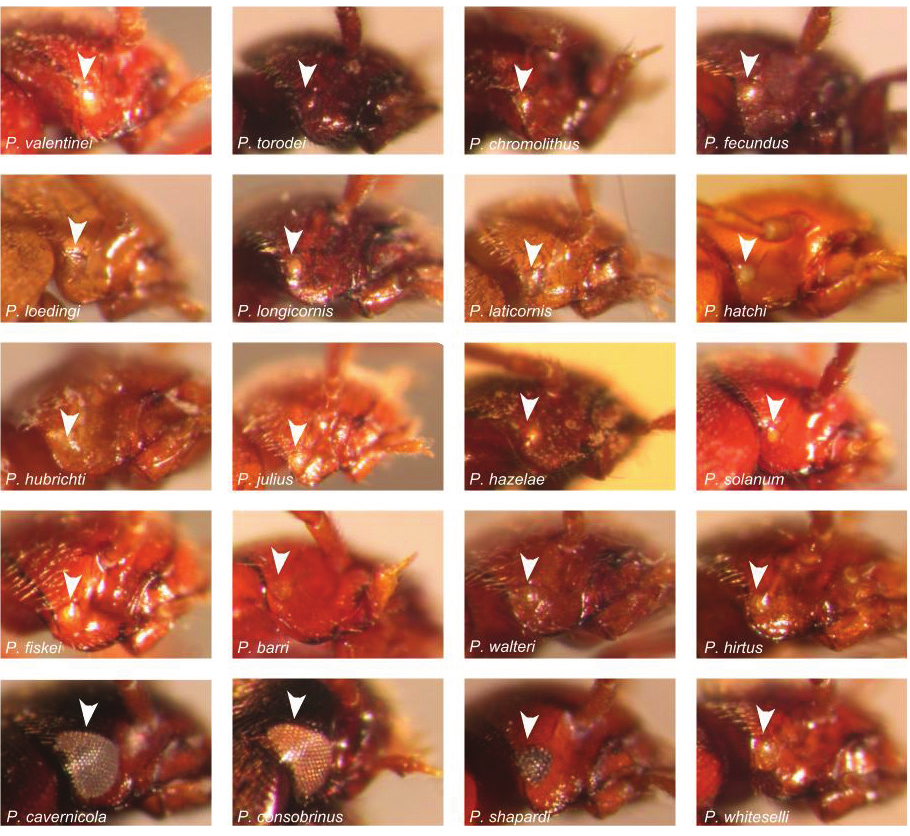
Figure 1. Eye morphologies in Ptomaphagus . Lateral view of head capsule and compound eye or eyelets (arrowheads) of Ptomaphagus species discussed in this paper. Ptomaphagus cavernicola and P. consobrinus are macrophthalmic and were used as outgroups in this study. Ptomaphagus shapardi , the only soil-dwell- ing species in the hirtus -group, has reduced eyes and is considered microphthalmic. The other 17 members of the hirtus -group are extremely